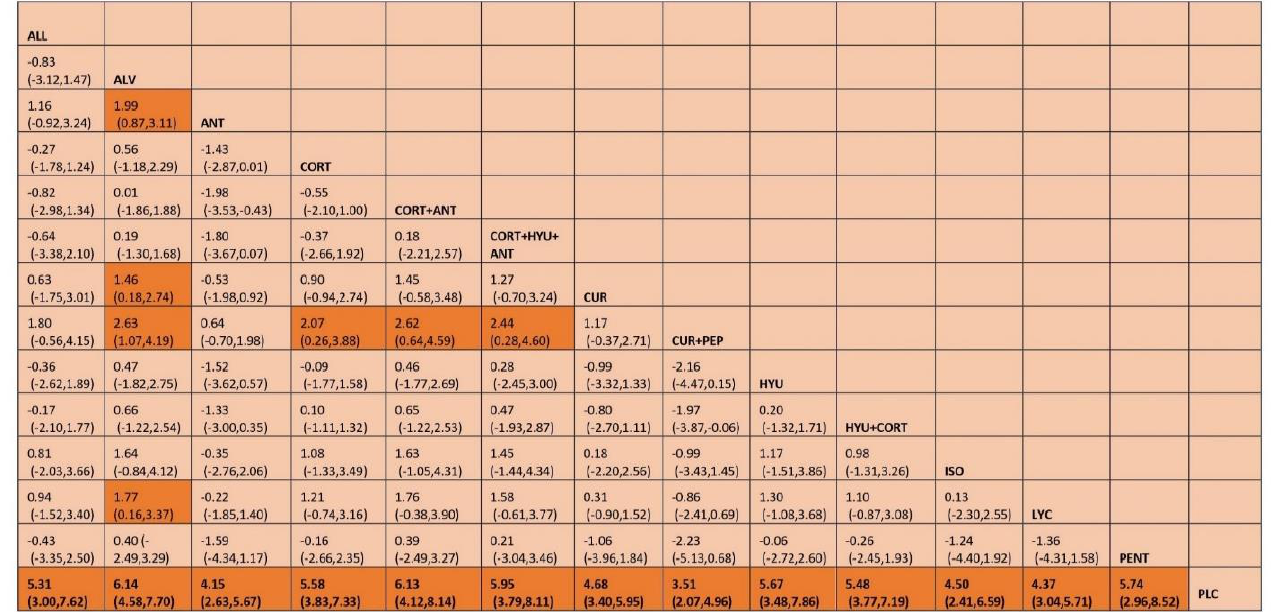
Figure 7. League table showing the results of the network meta-analyses comparing the effects of all drugs in improving mouth opening (MD) and 95% credible intervals Abbreviations: HYU—hyaluronidase; CORT—corticosteroid; LYC—lycopene; ALL—allicin; ANT—antioxidant; CUR— curcumin; ALV—aloe vera; PEP—piperine; PLC—placebo; ISO—isoxsuprine; Table 2. SUCRA ranking table for the comparative efficacy of different interventions used in the management of OSMF (burning sensation).